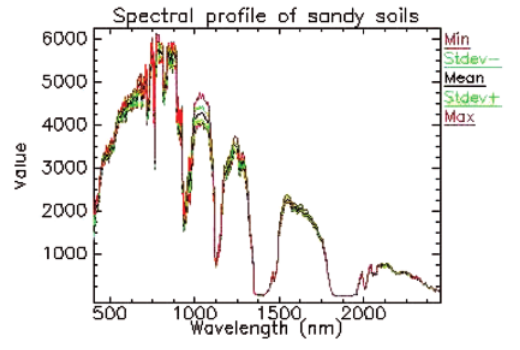
Figure 3. The spectral curves and the statistics of the spectral profile of the barren surface